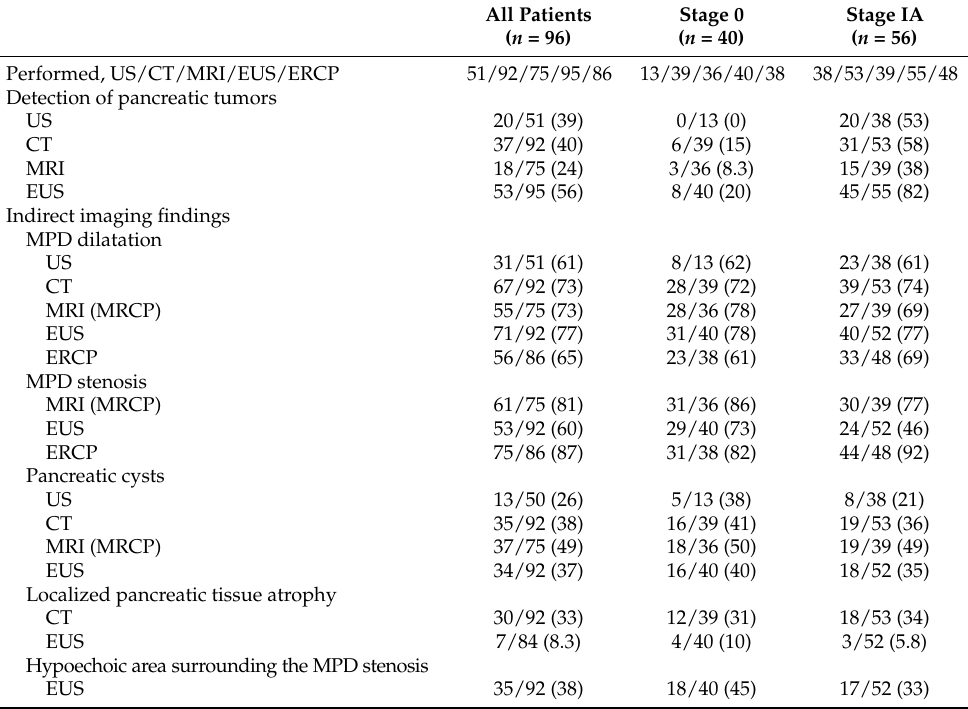
Table 4. Imaging findings and modalities in patients with stage 0 and IA